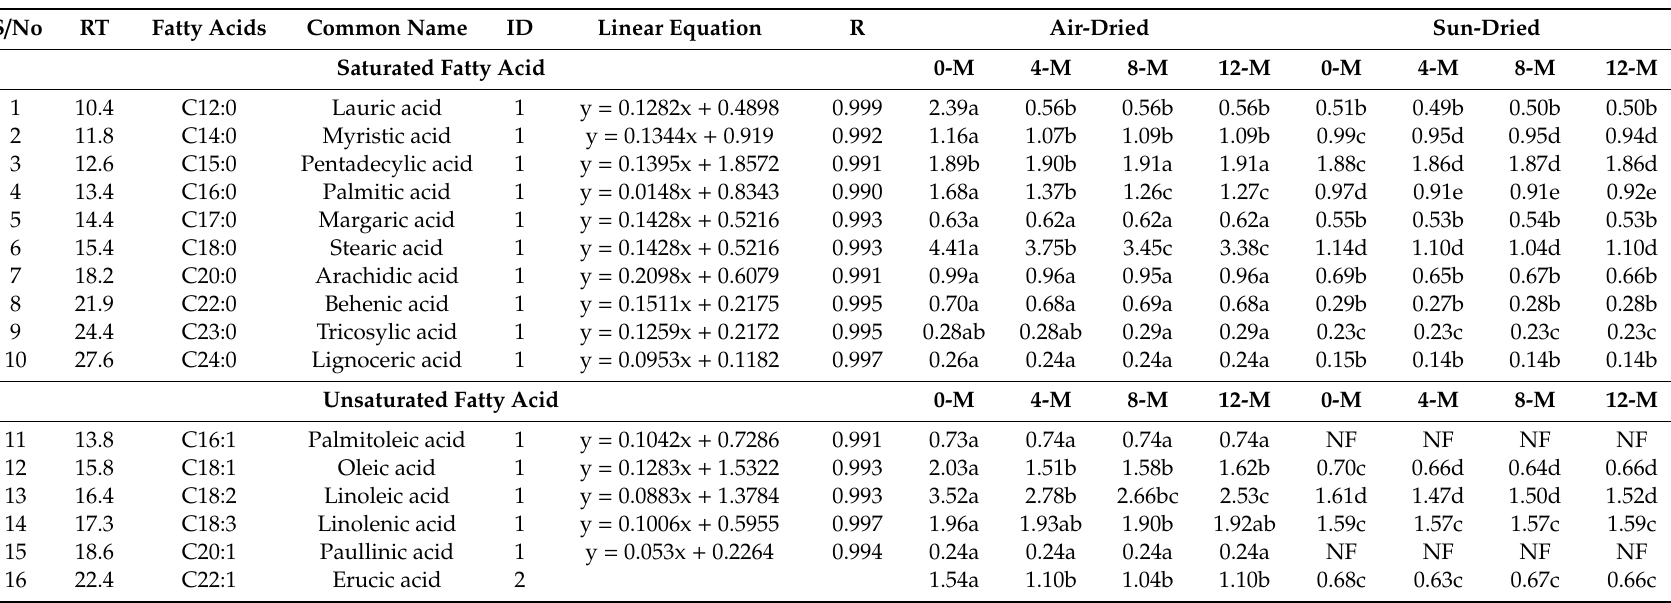
Table 1. Identification of di ff erent fatty acids (saturated and unsaturated) in air-dried and sun-dried raisins during